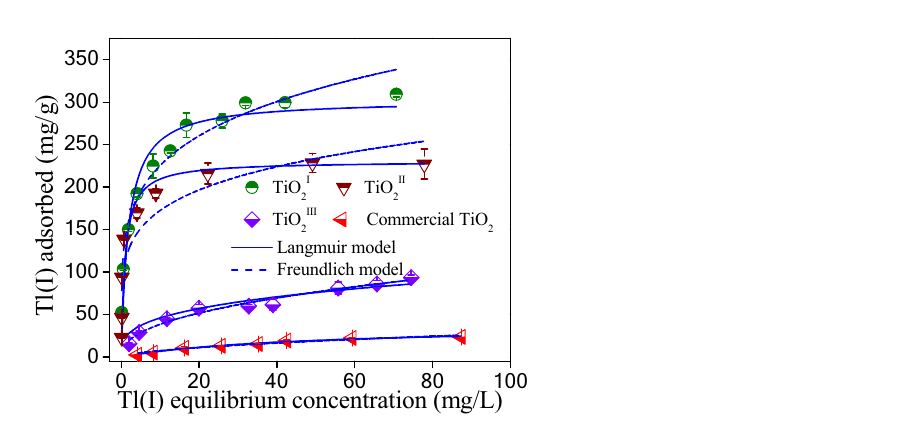
Figure 3. TEM images of TiO 2I ( a ), TiO 2II ( b ), TiO 2III ( c ) and commercial TiO 2 ( d ).